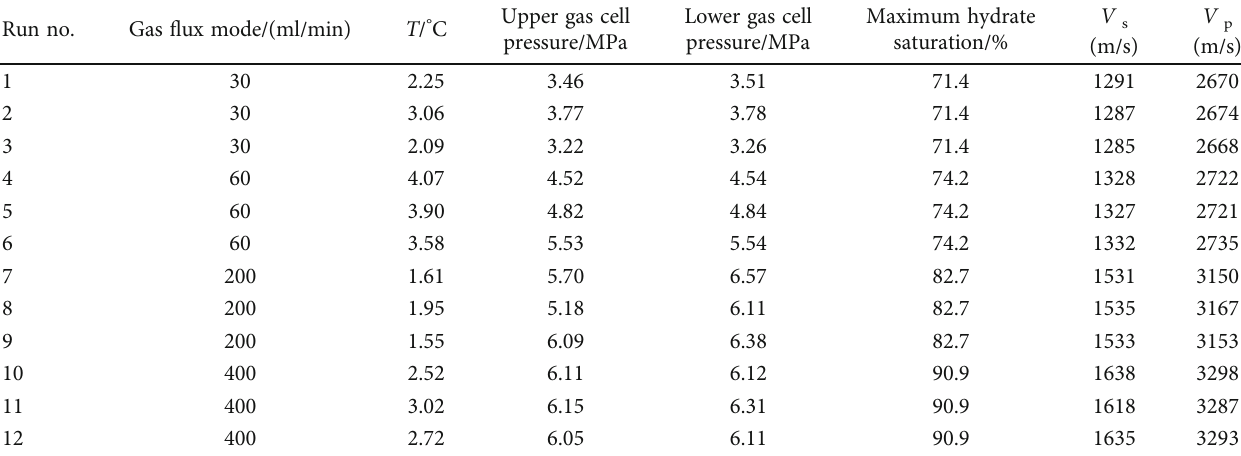
Table 1: E ff ect of methane fl ux on hydrate